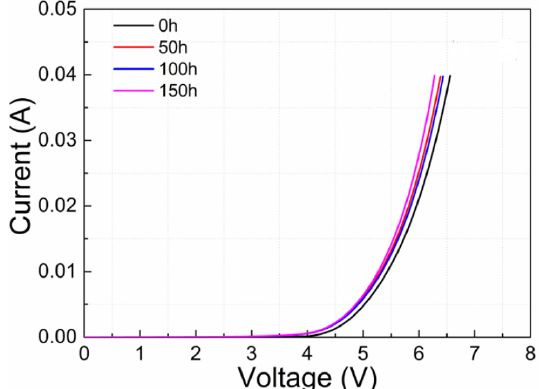
Figure 27. I-V characteristics of the 260 nm ultraviolet LED, measured at different stress times. Reproduced with permission. [81] Copyright 2019, Elsevier.